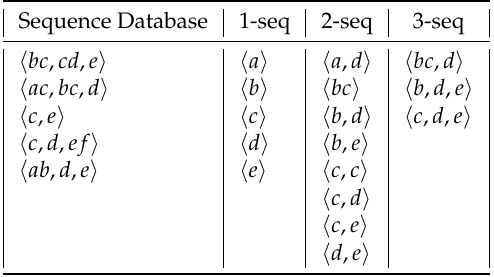
Figure 1. Example sequence database with mined sequential patterns using a minimum support of